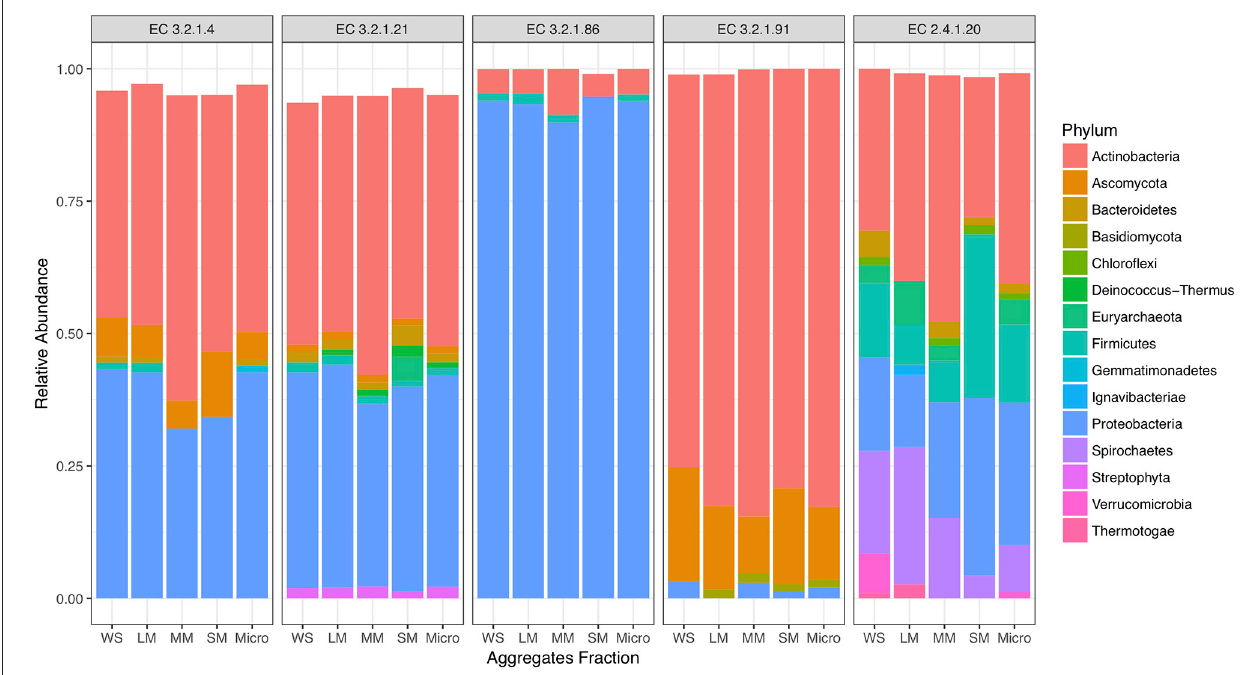
6-phospho- β -glucosidase (EC 3.2.1.86), cellobiohydrolases